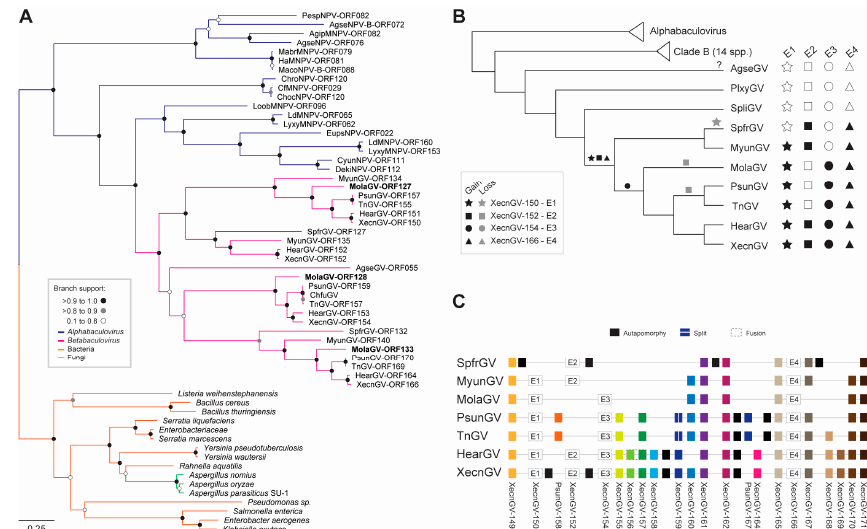
Figure 2. Enhancin evolution in MolaGV-related betabaculoviruses. ( A ) Phylogeny of enhancin homologs based on the predicted amino acid sequences by the Randomized Axelerated Maximum Likelihood ( RaxML) method under LG + I + G + F model. We hypothesized that an alphabaculovirus (purple branches) ancestor acquired the gene once from bacteria (orange branches) as happened also to a specific group of fungus (green branches) and then the gene was transferred toward betabaculoviruses (pink branches). The tree was midpoint rooted and presented as a cladogram for clarity; ( B ) Acquisition and presence of four different forms of the enhancin genes of betabaculoviruses; ( C ) Genomic contexts of the enhancin genes confirm the ancestral acquisition of themselves. Rectangles with similar colors depict orthology, and the black rectangles independent acquisitions. We named the enhancins according to the appearance in the XecnGV genome